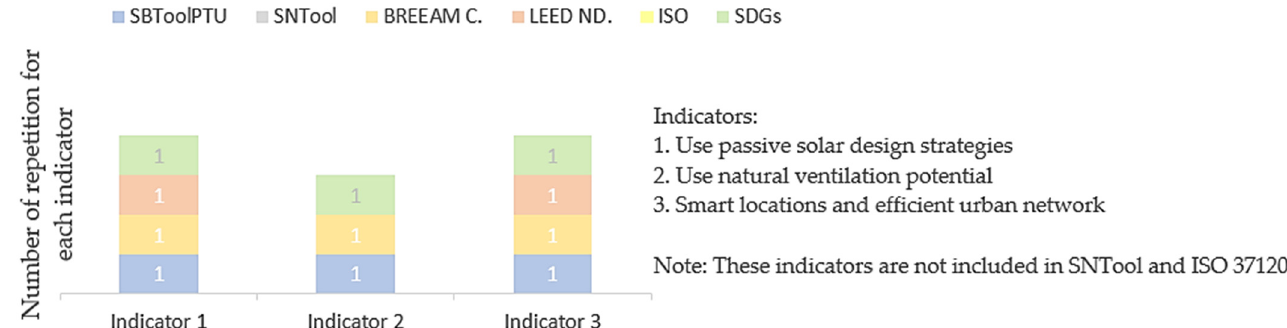
Figure 1. Frequency distribution of each indicator, relevant to the category of urban structure and form in SBTool PT _Urban (2018), SNTool Min (2020), BREEAM-C (2012), LEED-ND (2018), ISO 37120 and SDGs.